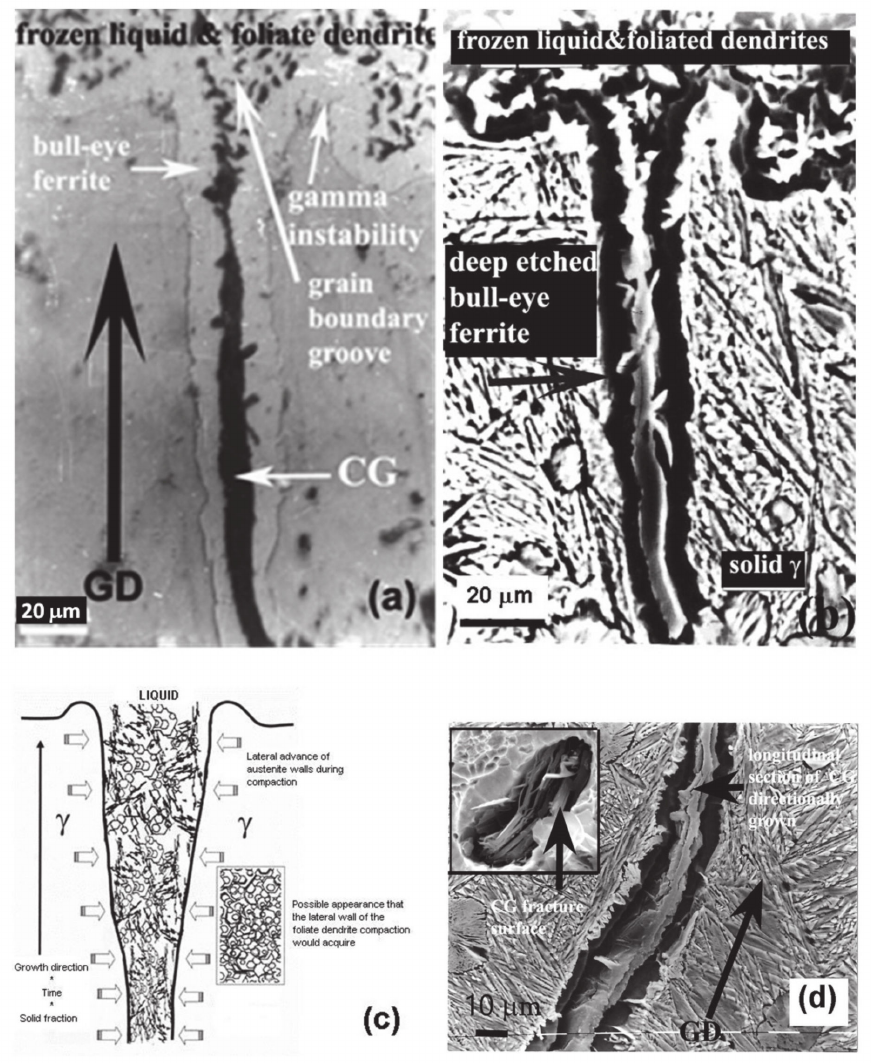
Figure 14. ( a ) Optical microscopy (OM) frozen interphase of growing CG; ( b ) idem SEM with deep etching; ( c ) compaction model; ( d ) CG showing compaction defects analogous to those showed on the fracture of Figure 5b.